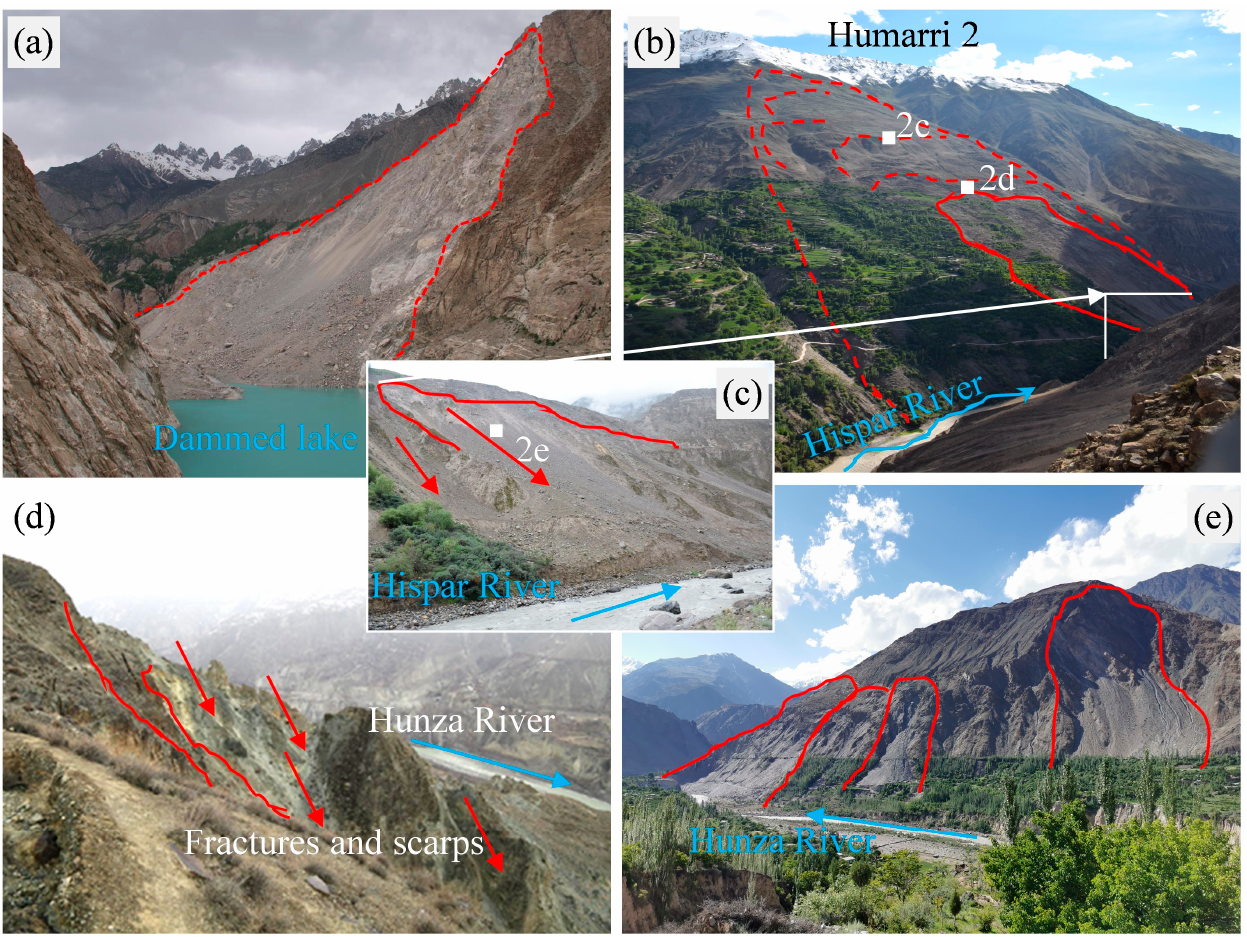
Figure 13. Photographs of a typical large landslide in the Hunza Valley controlled by the faults and river erosion. ( a ) Atta Abad. ( b , c ) Humarri-2 and secondary landslide, toe of Humarri. ( d ) Mayoon. ( e ) Jizalabad.